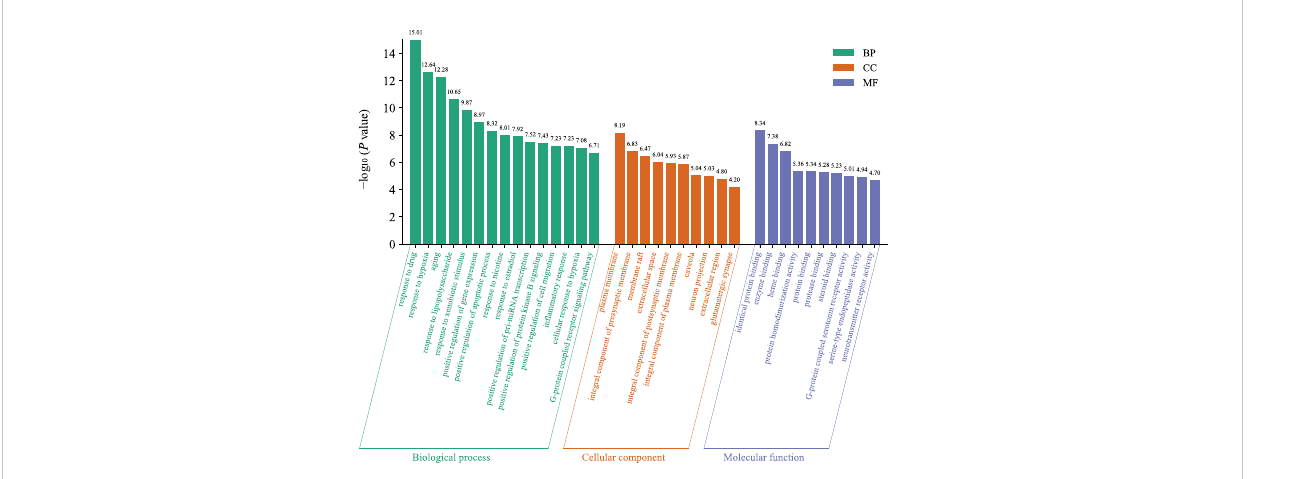
FIGURE 4 The GO function analyzes the histogram. BP is marked in teal, CC in sienna, and MF in steel blue. The bar graph is obtained by Bioinformatics